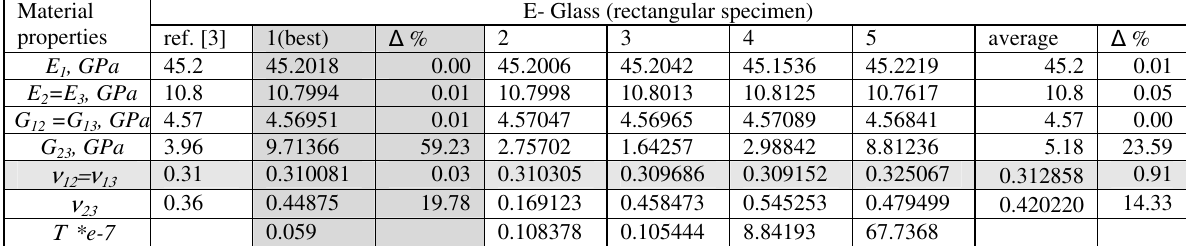
Table 4. Identified material properties of glass-epoxy specimen (rectangular specimen)